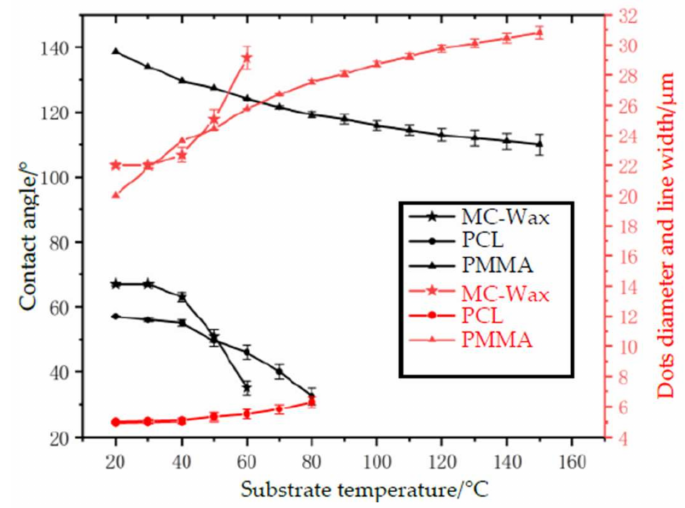
Figure 10. E ff ect of substrate temperature on printing